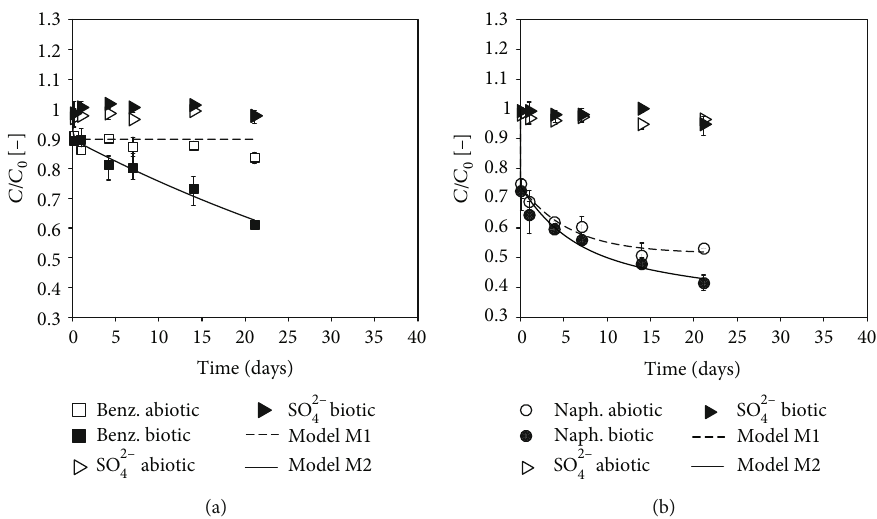
Figure 3: Sorption and biodegradation kinetics of benzene (a) and naphthalene (b) with soil A3 at high salinity (seawater).